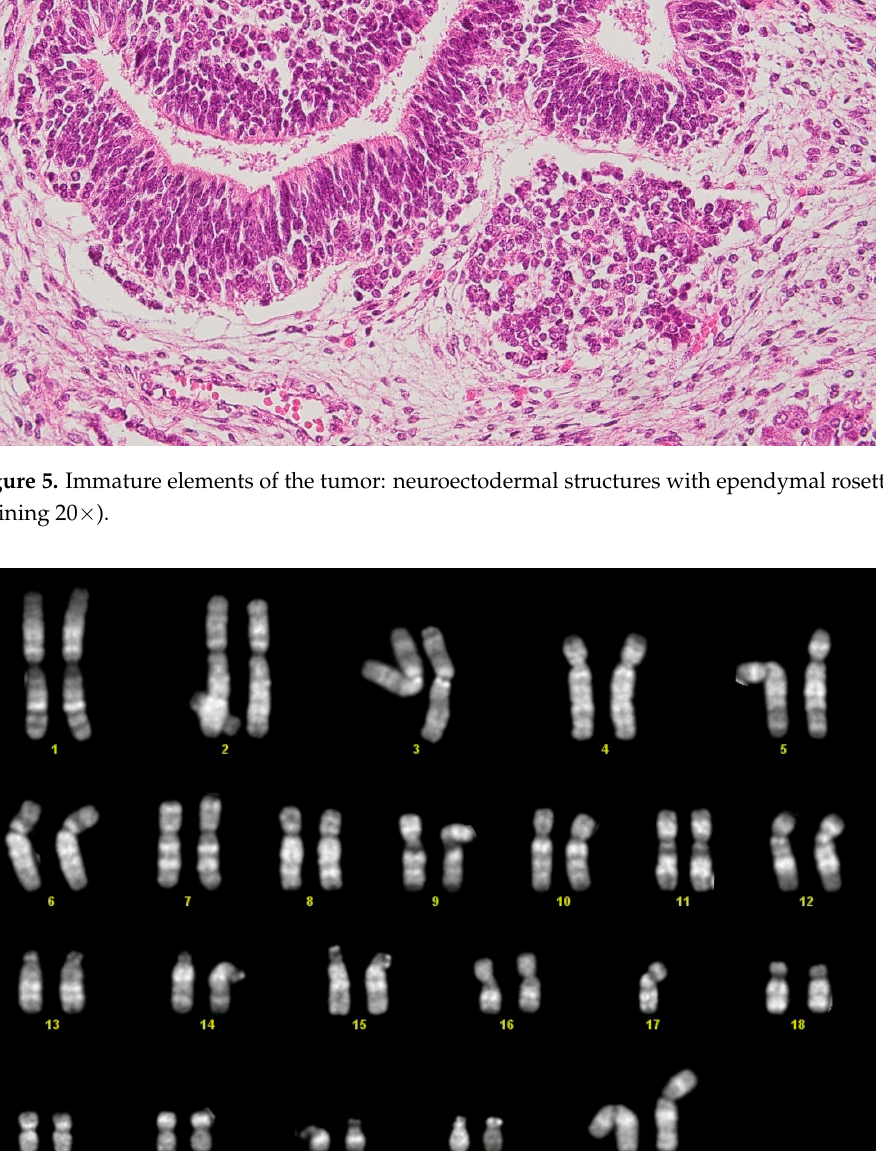
Figure 6. Tumor karyotype: female asset of 46,XX.